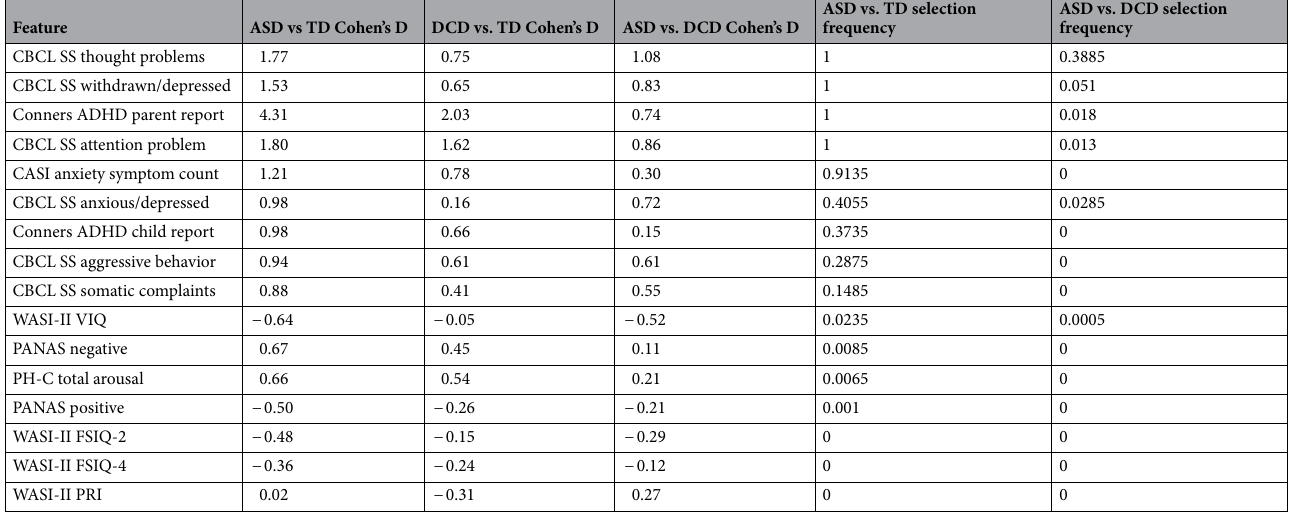
Table 4. Importance of non-social RDoC features in distinguishing ASD. The first three columns report Cohen’s d effect size from paired comparisons between subject groups. The last two columns report selection frequency of each feature by univariate feature selection for the full RDoC + M + S feature set across all 2000 cross validation loops for each of our two decoders (ASD vs. TD and ASD vs. DCD). Features (rows) sorted by selection frequency. Features represent the cognitive, arousal, positive and negative valence domains from the